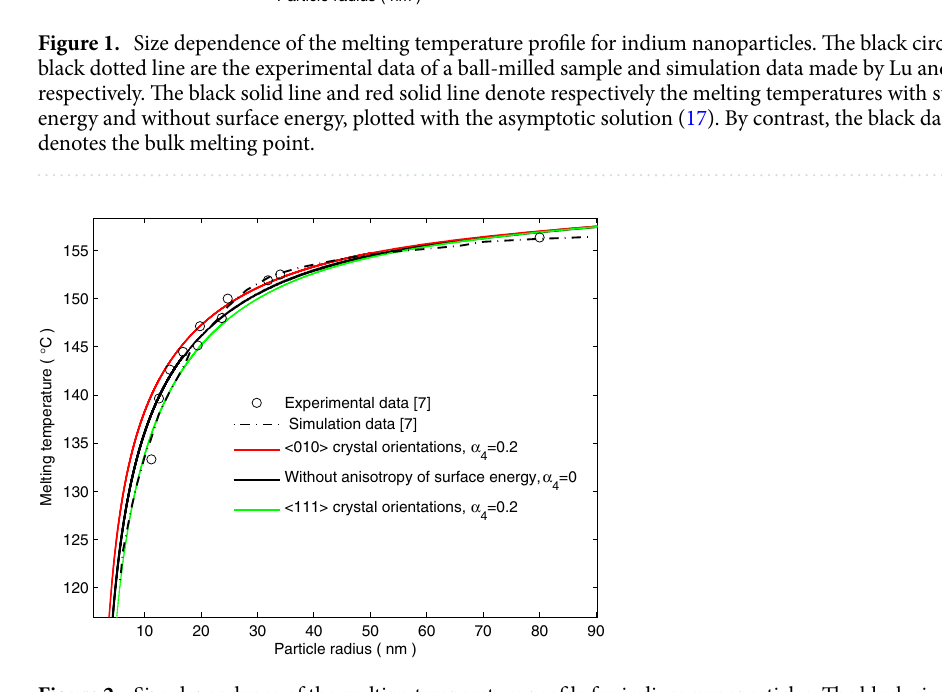
Figure 2. Size dependence of the melting temperature profile for indium nanoparticles. The black circles and black dotted line are the experimental data of a ball-milled sample and simulation data made by Lu and Jin 7 , respectively. The green and red lines denote the melting temperatures, plotted with the asymptotic solution (17) when the anisotropy of surface energy is considered. By contrast, the black solid line denotes the size dependent melting temperature reduction when disregarding the anisotropy of surface